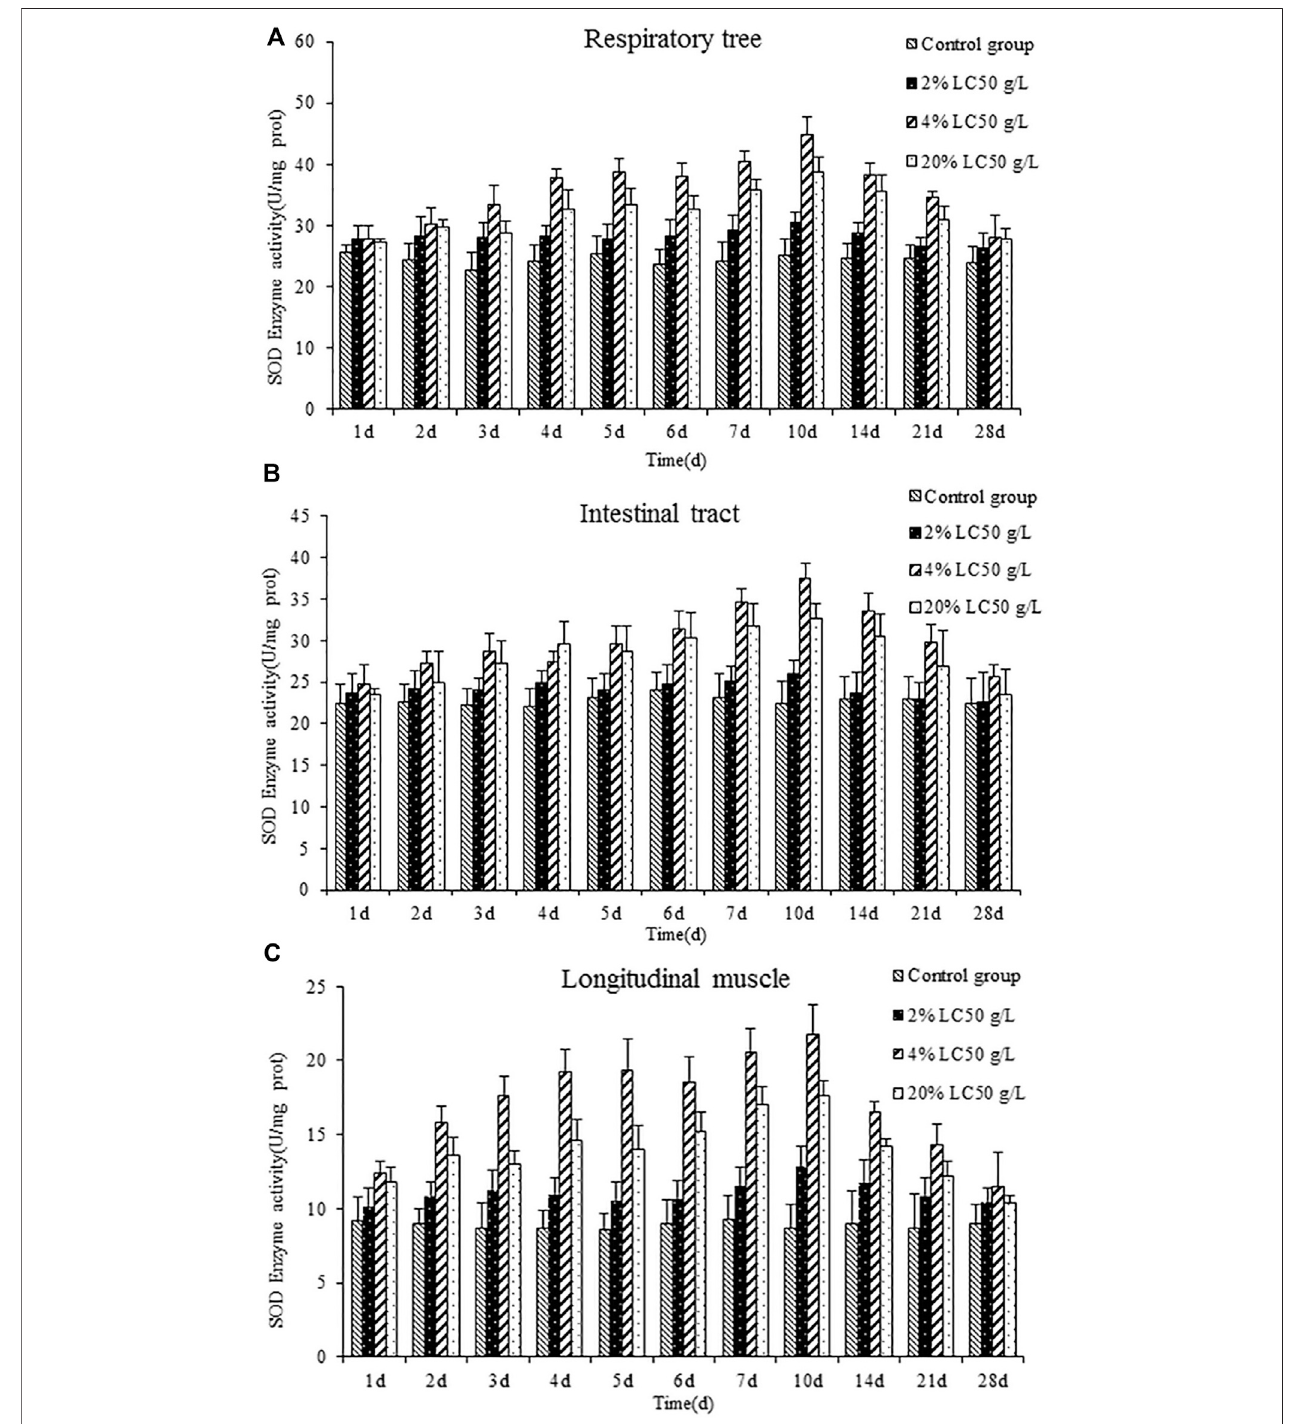
FIGURE 2 | SOD activity of the respiratory tree (A) , intestinal tract (B) , and longitudinal muscle (C) in A. japonicas .